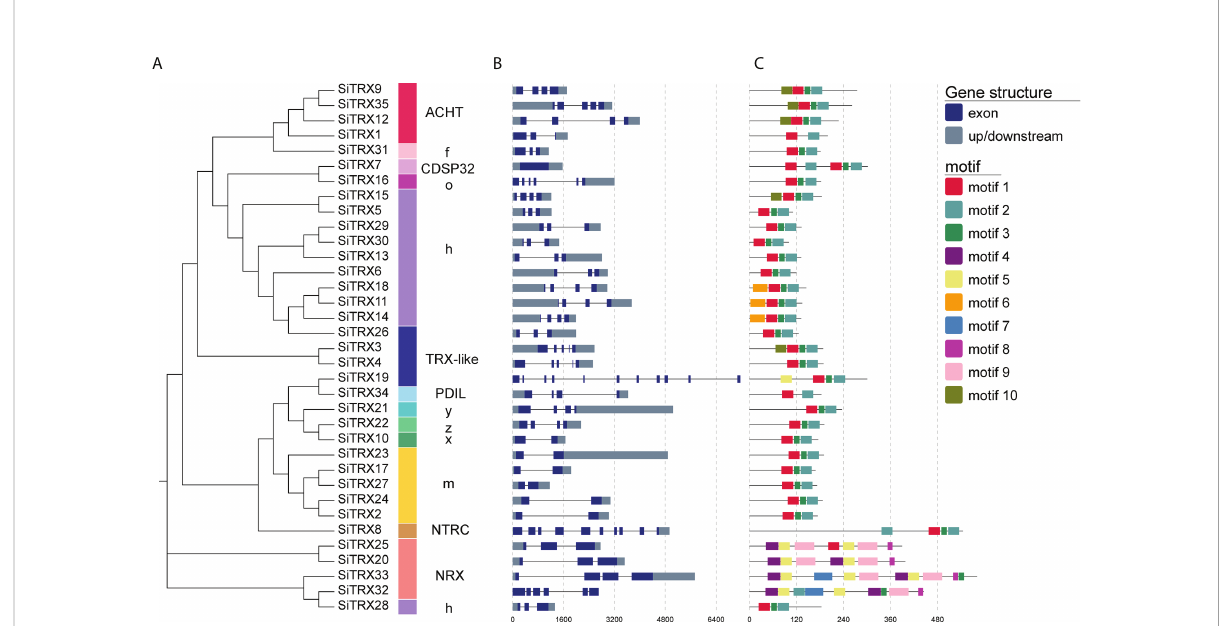
FIGURE 2 Evolutionary relationship, gene structure and conserved motif analysis of SiTRX members. (A) The evolutionary relationship of TRX in foxtail millet. (B) Gene structures of SiTRXs . The intron – exon structures were obtained by comparing the coding and genomic sequences using the GSDS website. (C) Motif composition, with the ten conserved motifs indicated with boxes of different